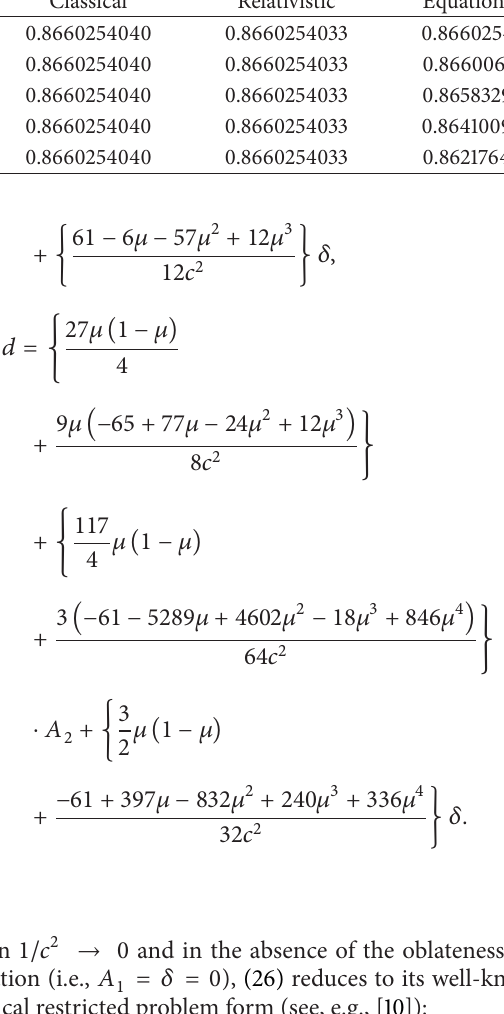
Table 3: Locations of triangular points. Sun-Jupiter system: 𝑐 = 22247.35 , 𝜇 = 0.000953692200 , and 𝐴 2 = 0.0000192887 × 10 −8 . 𝜉 ±𝜂 𝛿